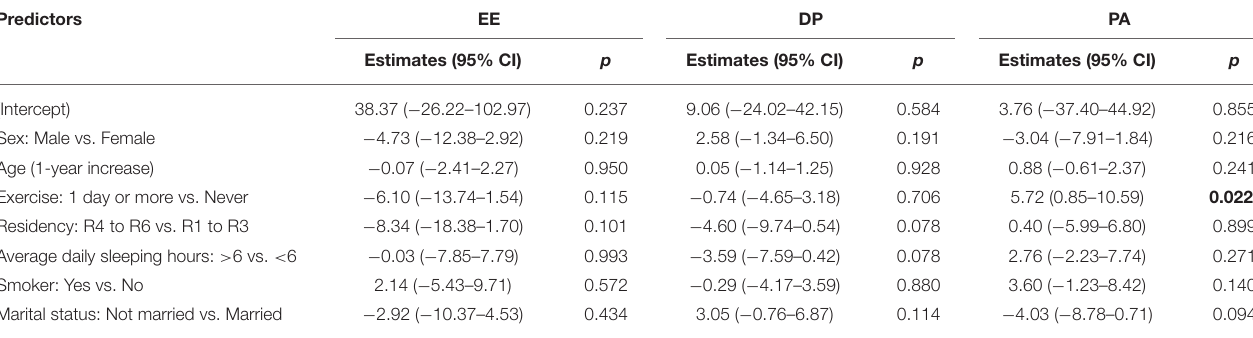
TABLE 5 | Sociodemographic and residency-related factors associated with high emotional exhaustion, high depersonalization, and low personal accomplishment scores.